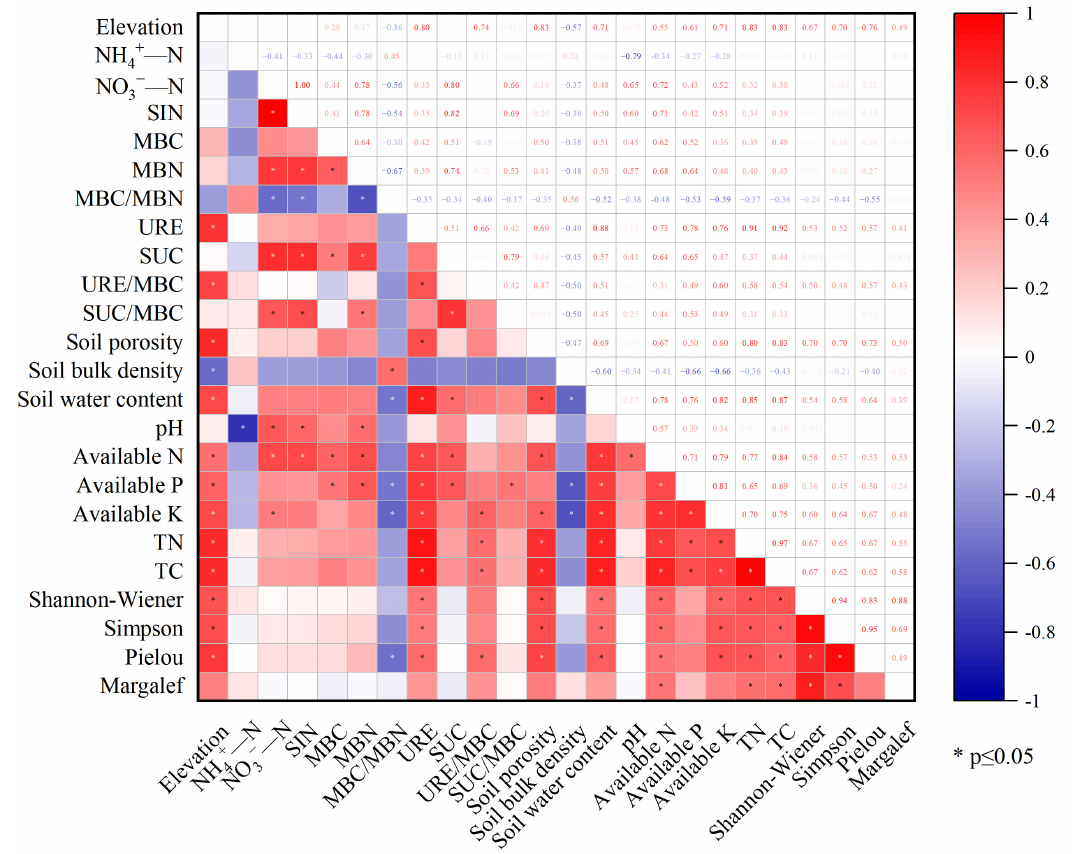
Figure 5. Pearson correlation analysis of the active soil substances with environmental factors and soil physicochemical properties at different elevation gradients.